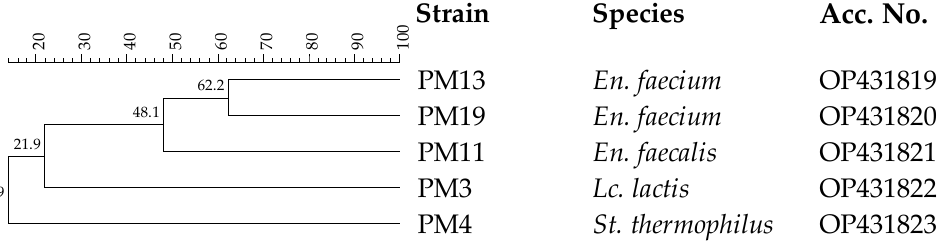
Table 3. Physicochemical traits of Primosale cheeses.